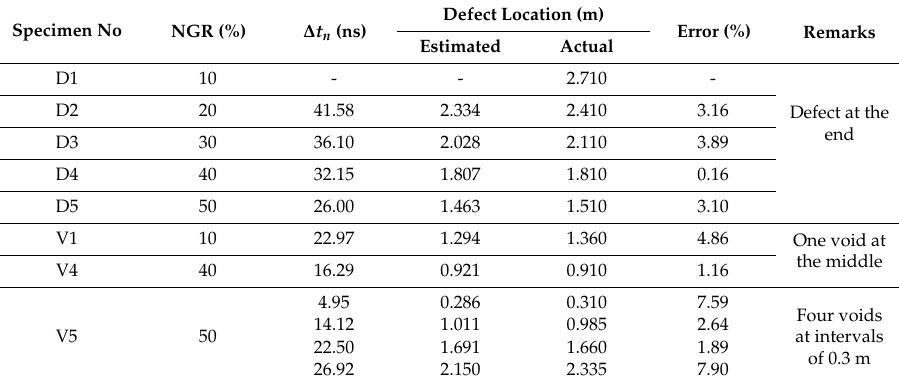
Table 3. Round-trip travel times reflected at defects ( ∆ t n ) and estimated defect locations for defective rock bolts in embedded